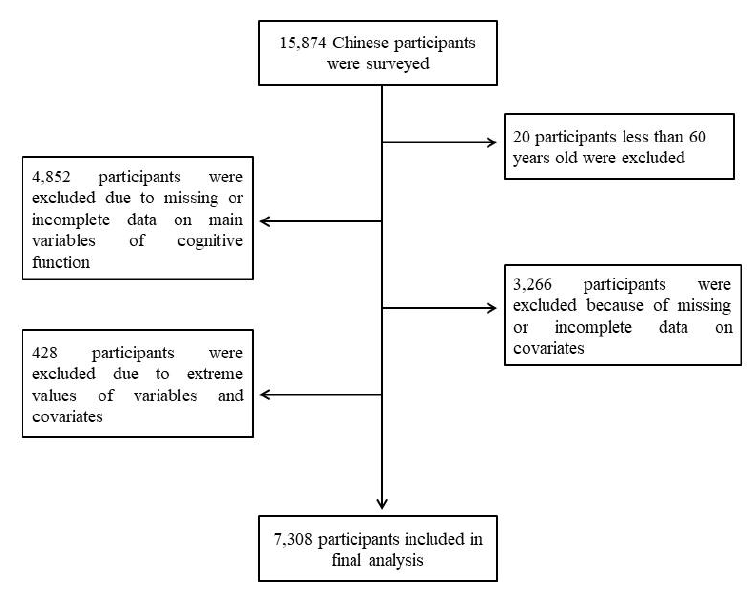
Figure 1. Flow diagram of participants’ study exclusion and inclusion.